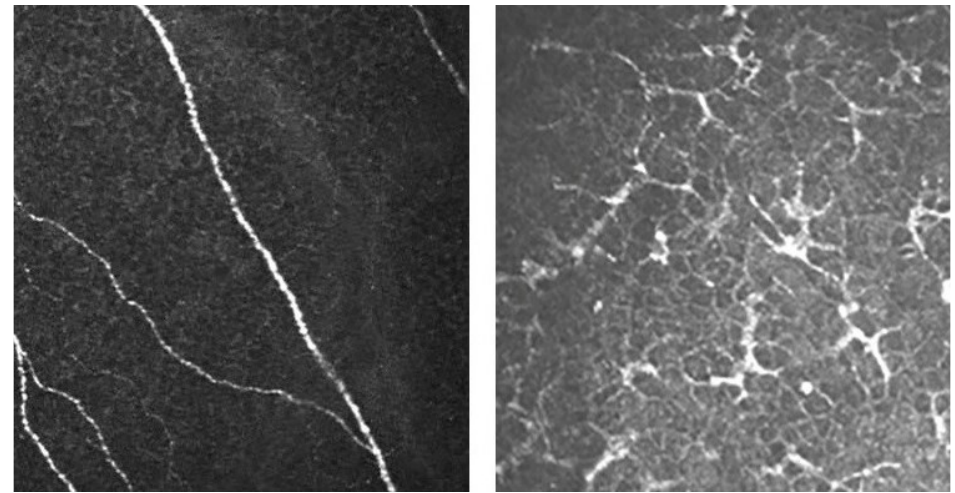
Figure 3. In vivo confocal microscopic images of a normal eye at the level of deep epithelium to sub-basal nerve plexus ( left ). Langerhans cells as dendritic inflammatory cells at the same level during active herpes simplex keratitis ( right ).